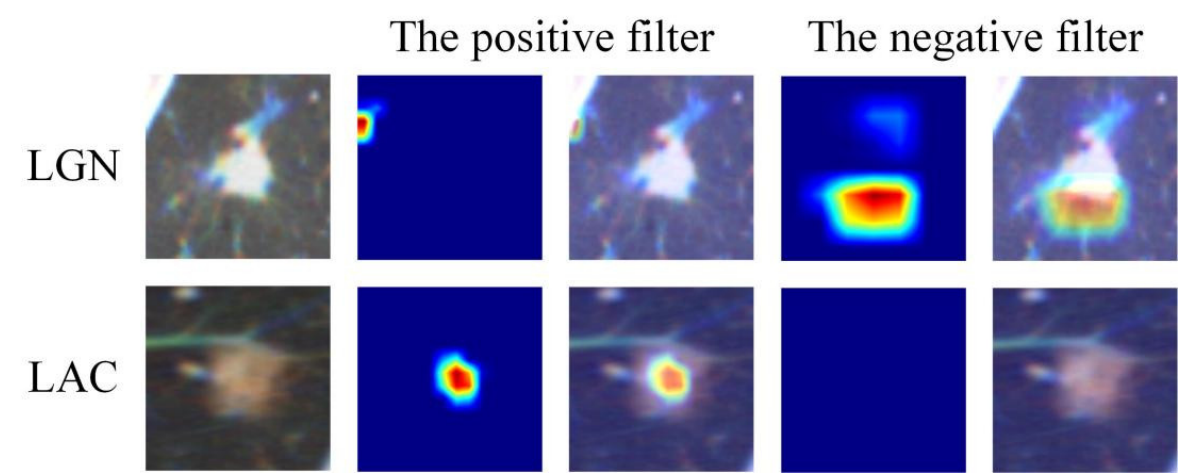
Figure 3. Visualization of two patient samples for TLS-LW. In the second and fourth columns, the heatmaps of the two convolution kernels are noted for two patients. In the third and fifth columns, the combination maps of two convolution kernel heatmaps and input data are noted for two patients. The red region represents a larger weight, which shows that the model focuses on the area of the CT image. Note: TLS-LW, transfer learning signature based on lung cancer WSI; LAC, lung ad- enocarcinoma; LGN, lung granulomatous nodule.